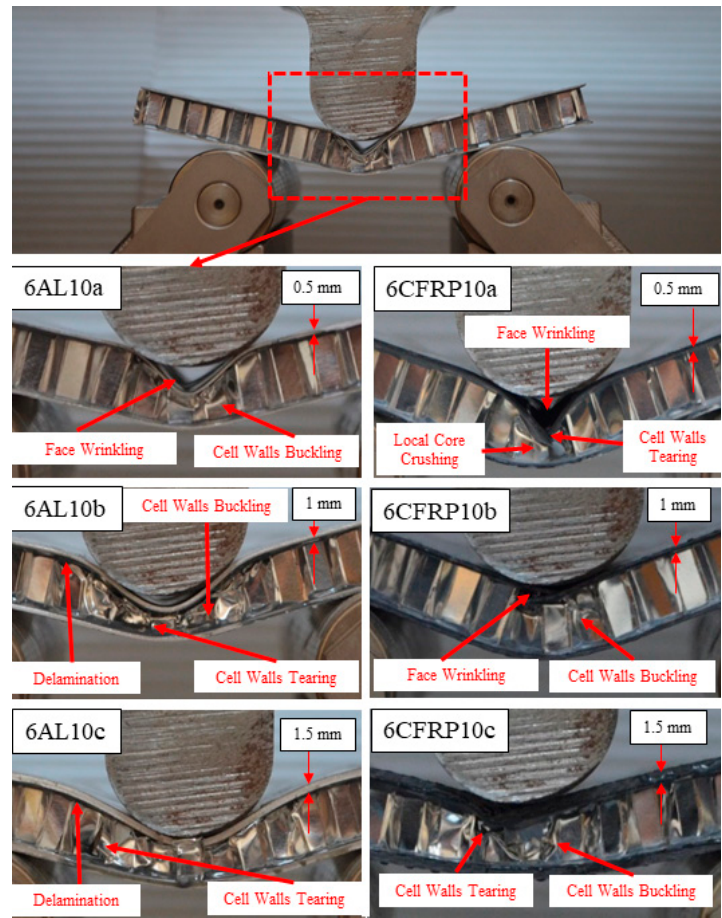
Figure 5. Specimen images obtained after three-point bending tests.